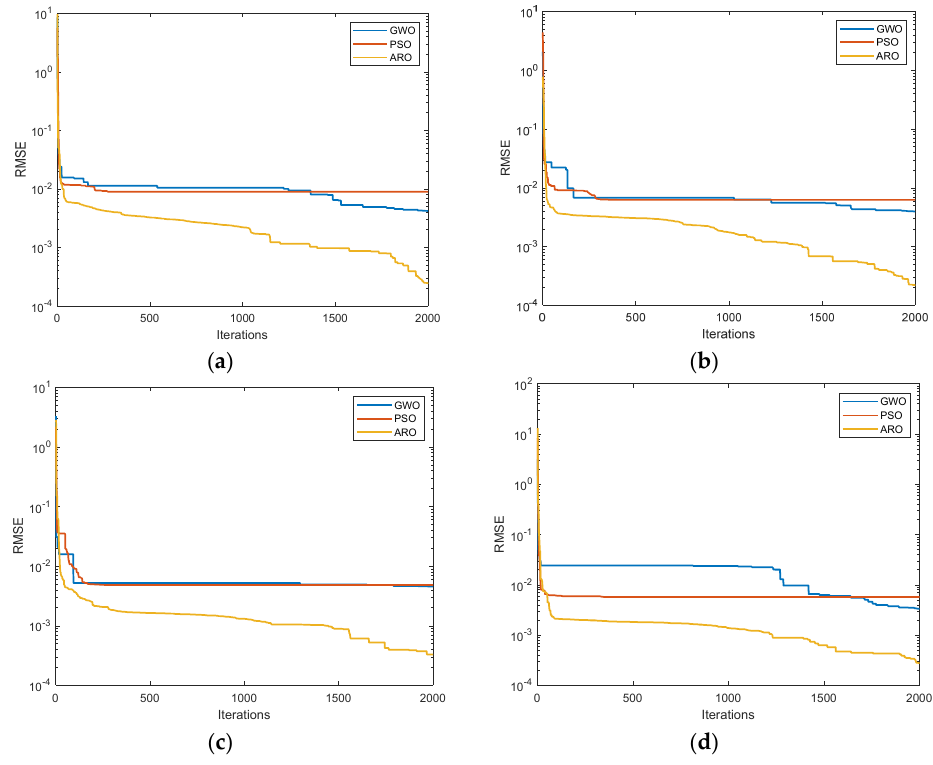
Figure 15. Convergence graphs of different algorithms at various environmental conditions: ( a ) 1 atm, 1173 K; ( b ) 1 atm, 1273 K; ( c ) 3a tm, 1173 K; and ( d ) 3 atm, 1273